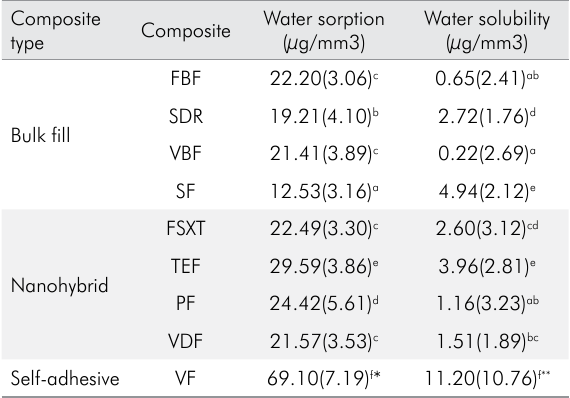
Table 3. Results of water sorption and solubility. Composite